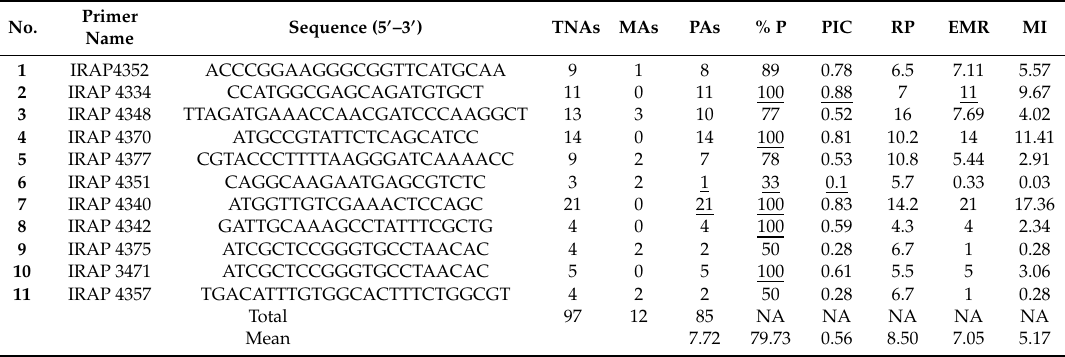
Table 2. IRAP primer names, sequences, total number of amplicons (TNAs), monomorphic amplicons (MAs), polymorphic amplicons (PAs), percentage of polymorphism (%P), polymorphism information content (PIC), resolving power (RP), e ff ective multiplex ratio (EMR), and marker index (MI) as revealed by IRAP profiles in 11 M. sativa L.